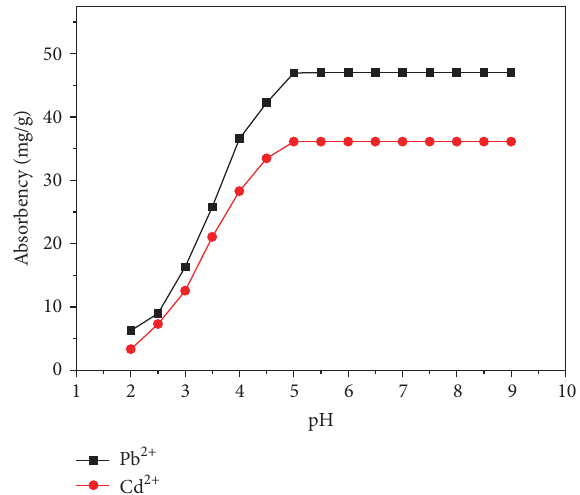
Figure 4: Effect of solution pH on adsorbed Pb 2+ and Cd 2+ . Figure 5: Effect of the initial concentration on absorbed Pb